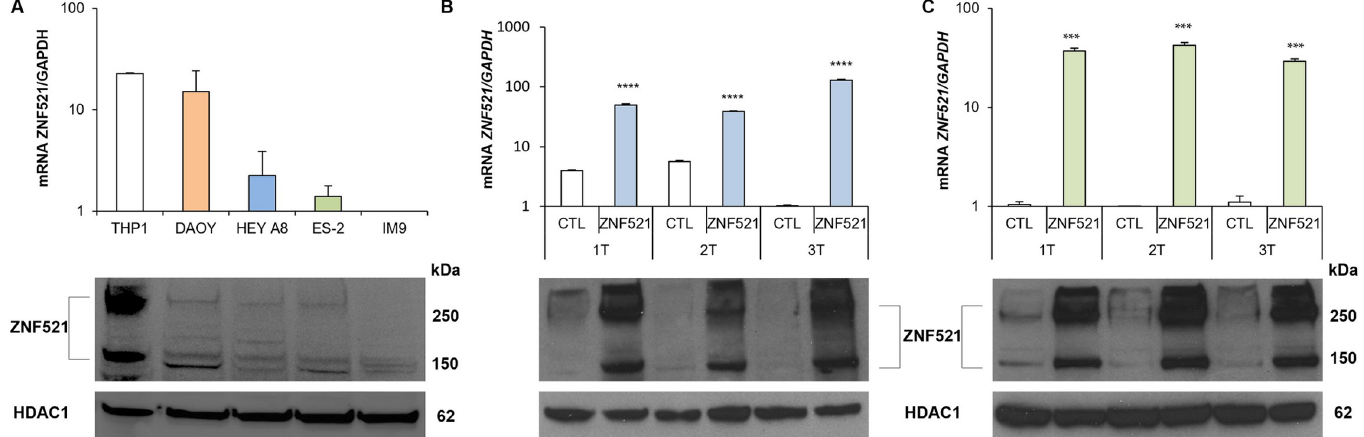
Fig 1. Expression of ZNF521 in HeyA8 and ES-2 human ovarian carcinoma cell lines. Endogenous ZNF521 mRNA (A, top panel: qRT-PCR) and protein (A, bottom panel: Nuclear protein detected by Western Blotting) expression in human ovarian carcinoma cell lines (HeyA8 and ES-2) compared to THP1 cells, that express high levels of ZNF521, DAOY cells, that express intermediate levels and IM9 cells that express low levels of ZNF521. Modulation of ZNF521 by lentiviral transduction mRNA (B and C, top panel: qRT-PCR) and protein expression (B and C, bottom panel: Nuclear protein detected by Western Blotting) in HeyA8 (B) and ES-2 (C) cells transduced with lentiviral vectors containing the cDNAs for ZNF521 compared to the control (CTL). “T” in 1T, 2T or 3T indicate each “Transduction”. The two bands for ZNF521 correspond to the monomer and dimers at 150kDa and 300kDa identified by the S15 anti-ZNF521 antibody. The nuclear extracts are normalized for the HDAC1 protein. Asterisks indicate p < 0,05 � , p < 0,01 �� , p < 0,001 ��� , p < 0,0001 ���� .